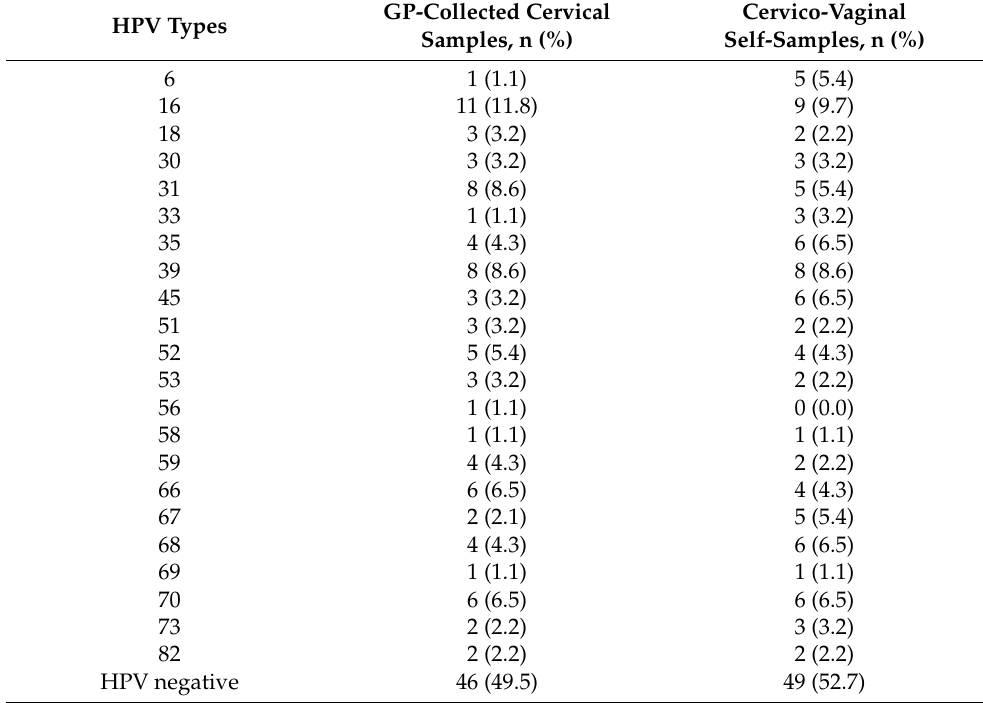
Table 1. HPV types detected with NGS-panel in GP-collected cervical samples and cervico-vaginal